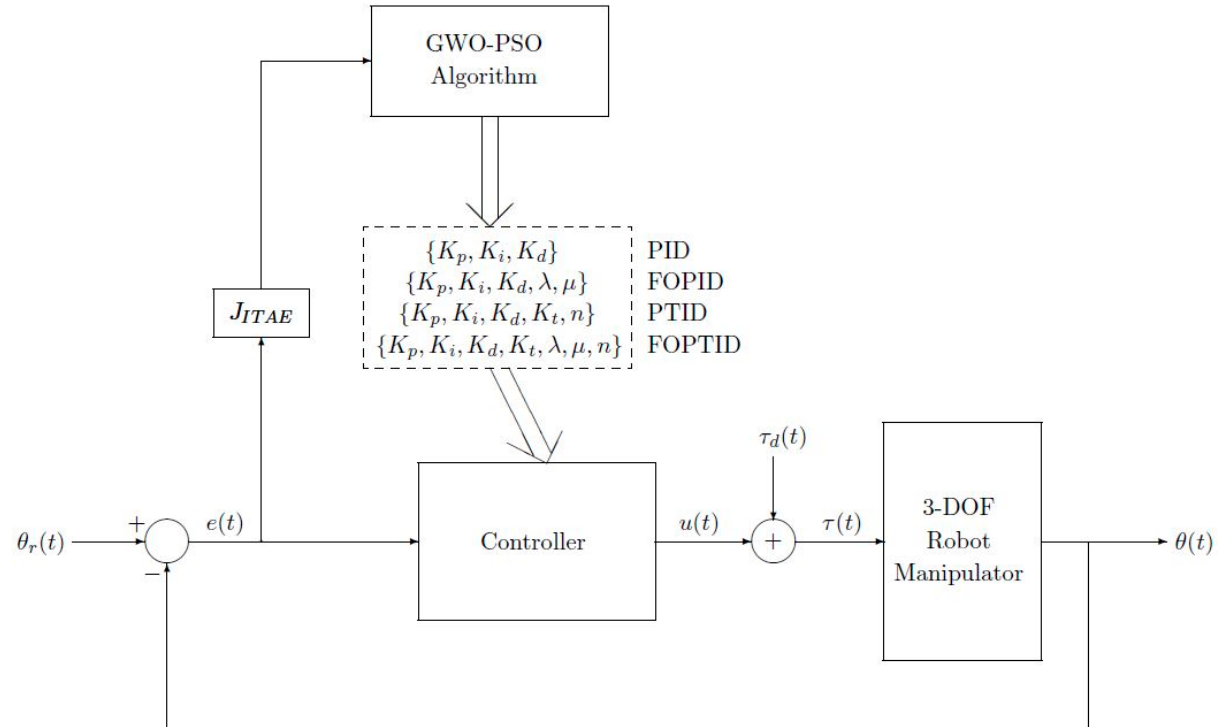
Figure 9. The schematic diagram of the proposed control